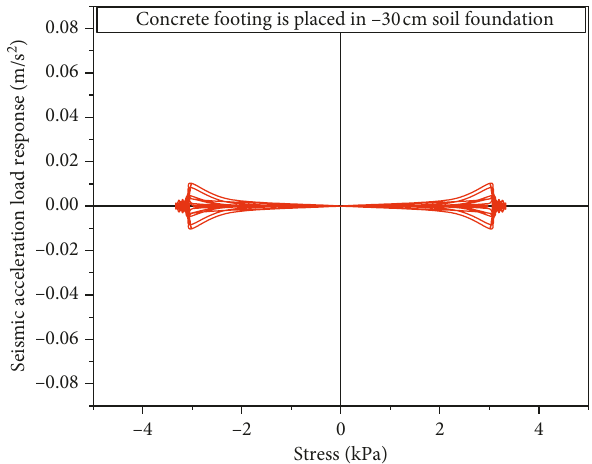
Figure 14: Seismic acceleration load response vs stress at the base of a concrete footing, during concrete footing-soil foundation